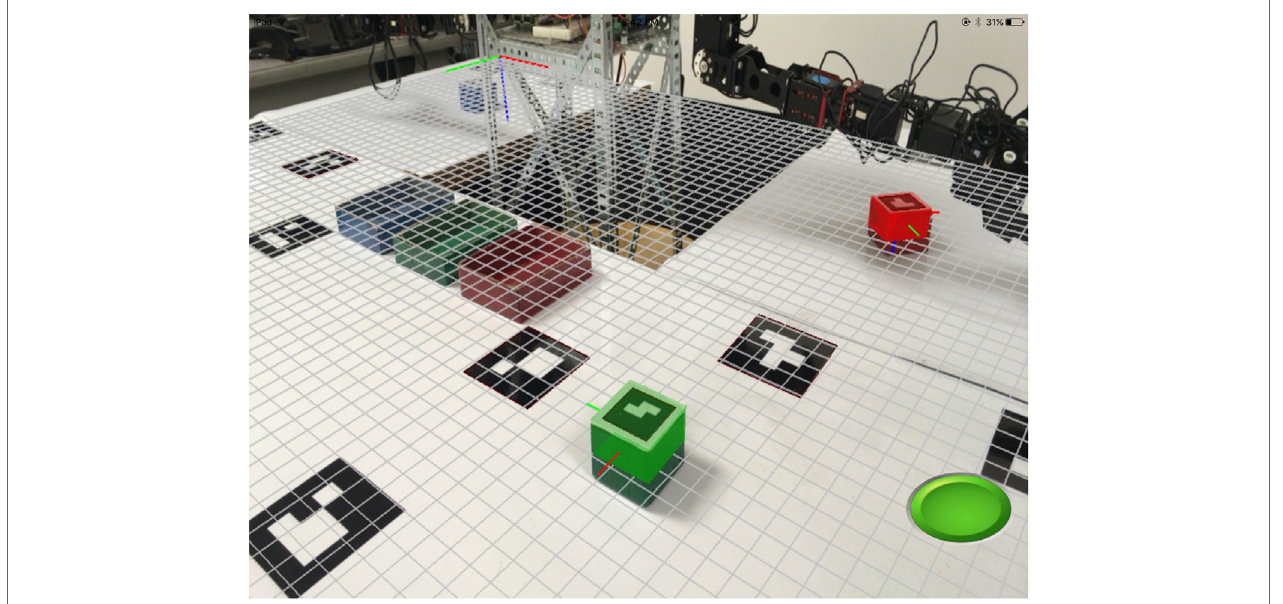
FigUre 8 | Mobile view of the workspace as captured from the tablet’s rear-facing camera